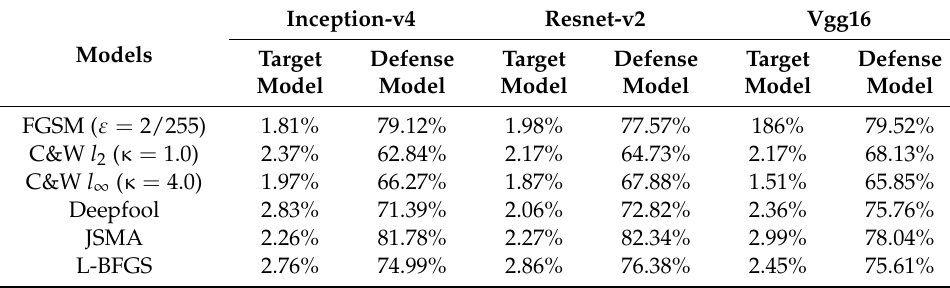
Table 4. The results of the proposed method under the defense-aware scenarios.